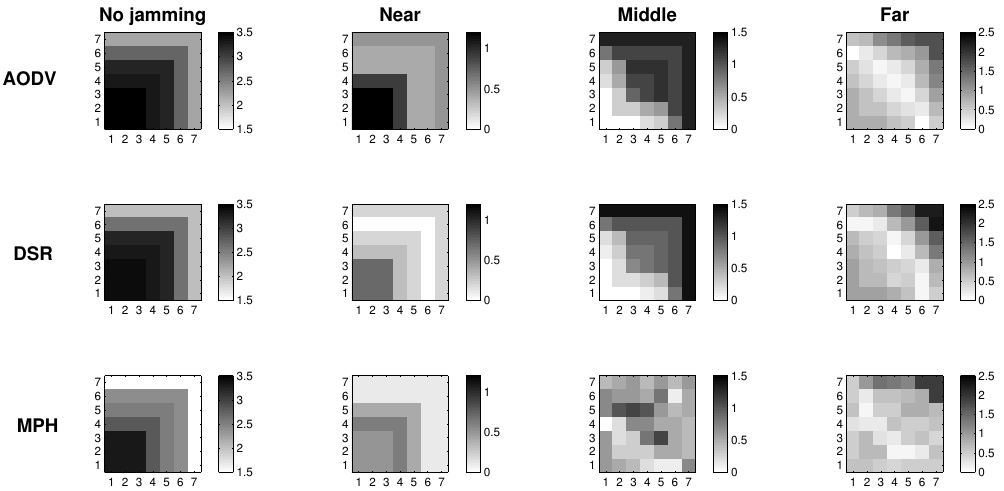
Figure 8. 2D representation of the average CSMA retries in the no jamming case and the difference between the values in the reactive and no jamming cases for each of the positions of the jammer node.